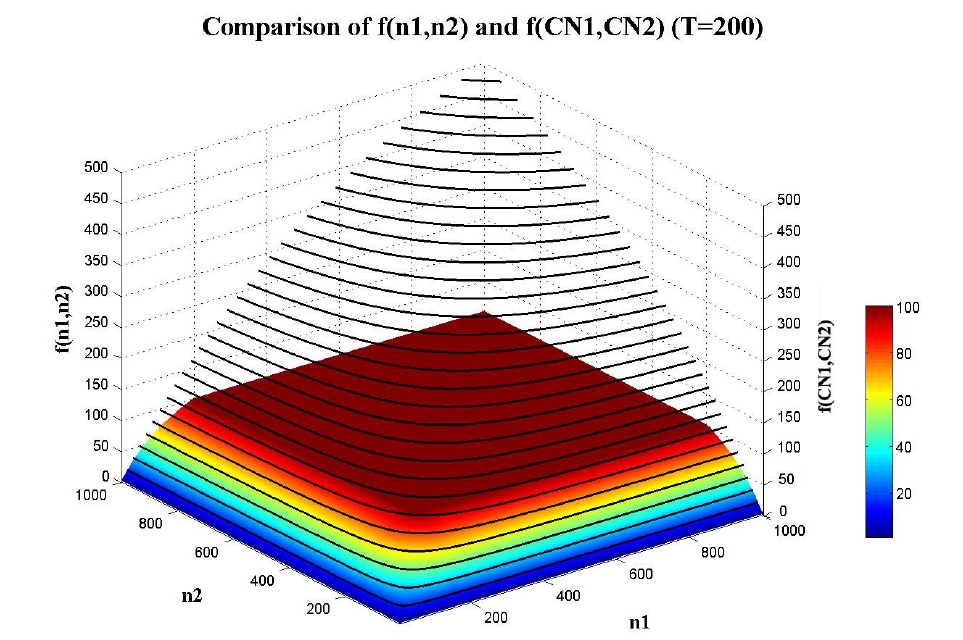
Figure 4. Comparison of f(n 1 , n 2 ) and f(CN 1 , CN 2 ) . The black contour is the plot for f(n 1 , n 2 )